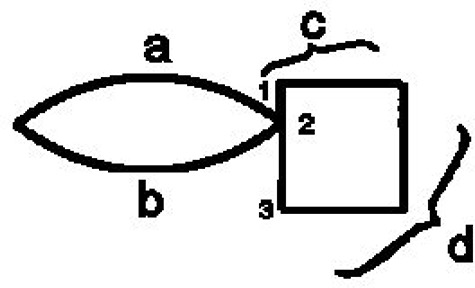
Law of closure (Wertheimer, 1923).